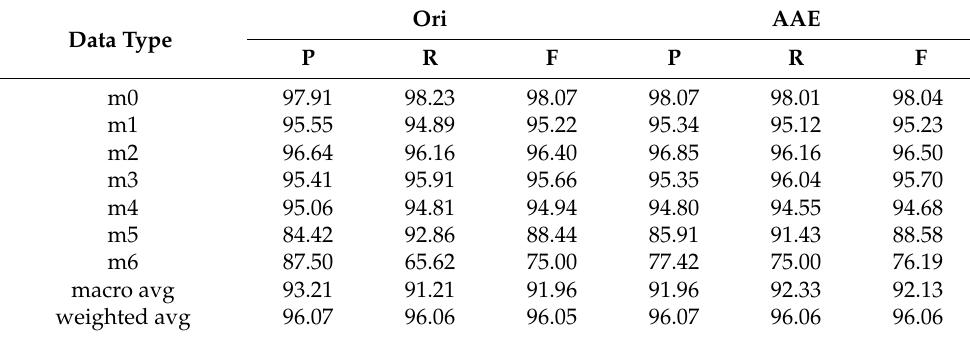
Table 5. Classification of M0–M6 subdwarfs with data